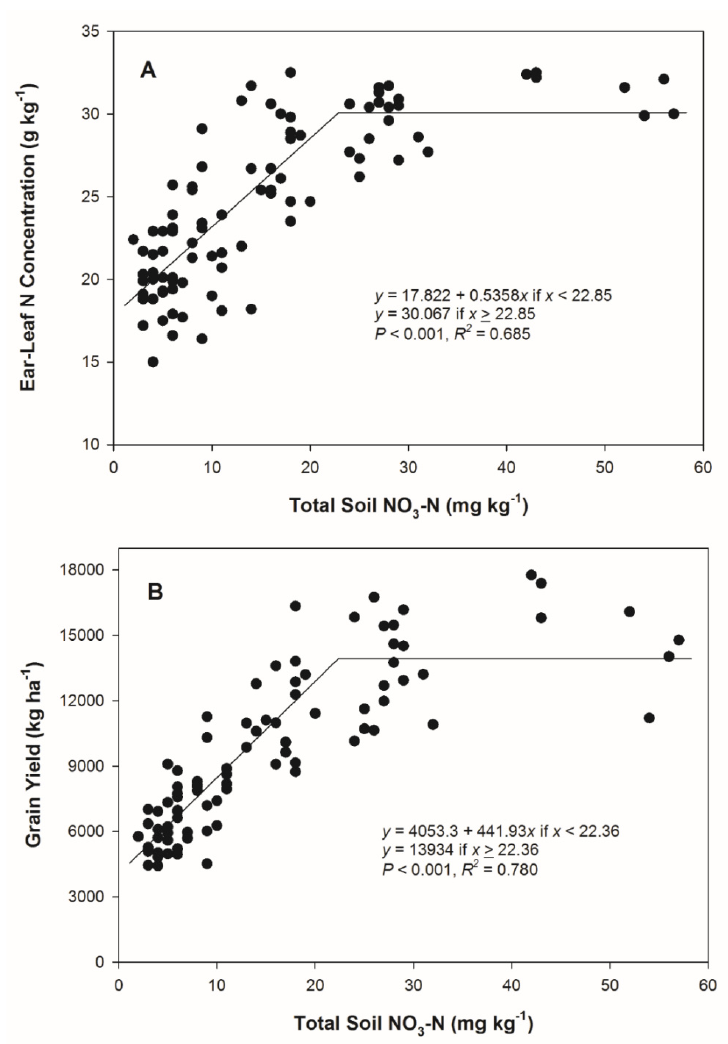
Figure 2. ( A ) Ear-leaf N concentration at R1 as impacted by soil nitrate-nitrogen (NO 3 -N) 14 days after flood initiation in 2018. ( B ) Grain yield as impacted by total soil NO 3 -N 14 days after flood initiation in